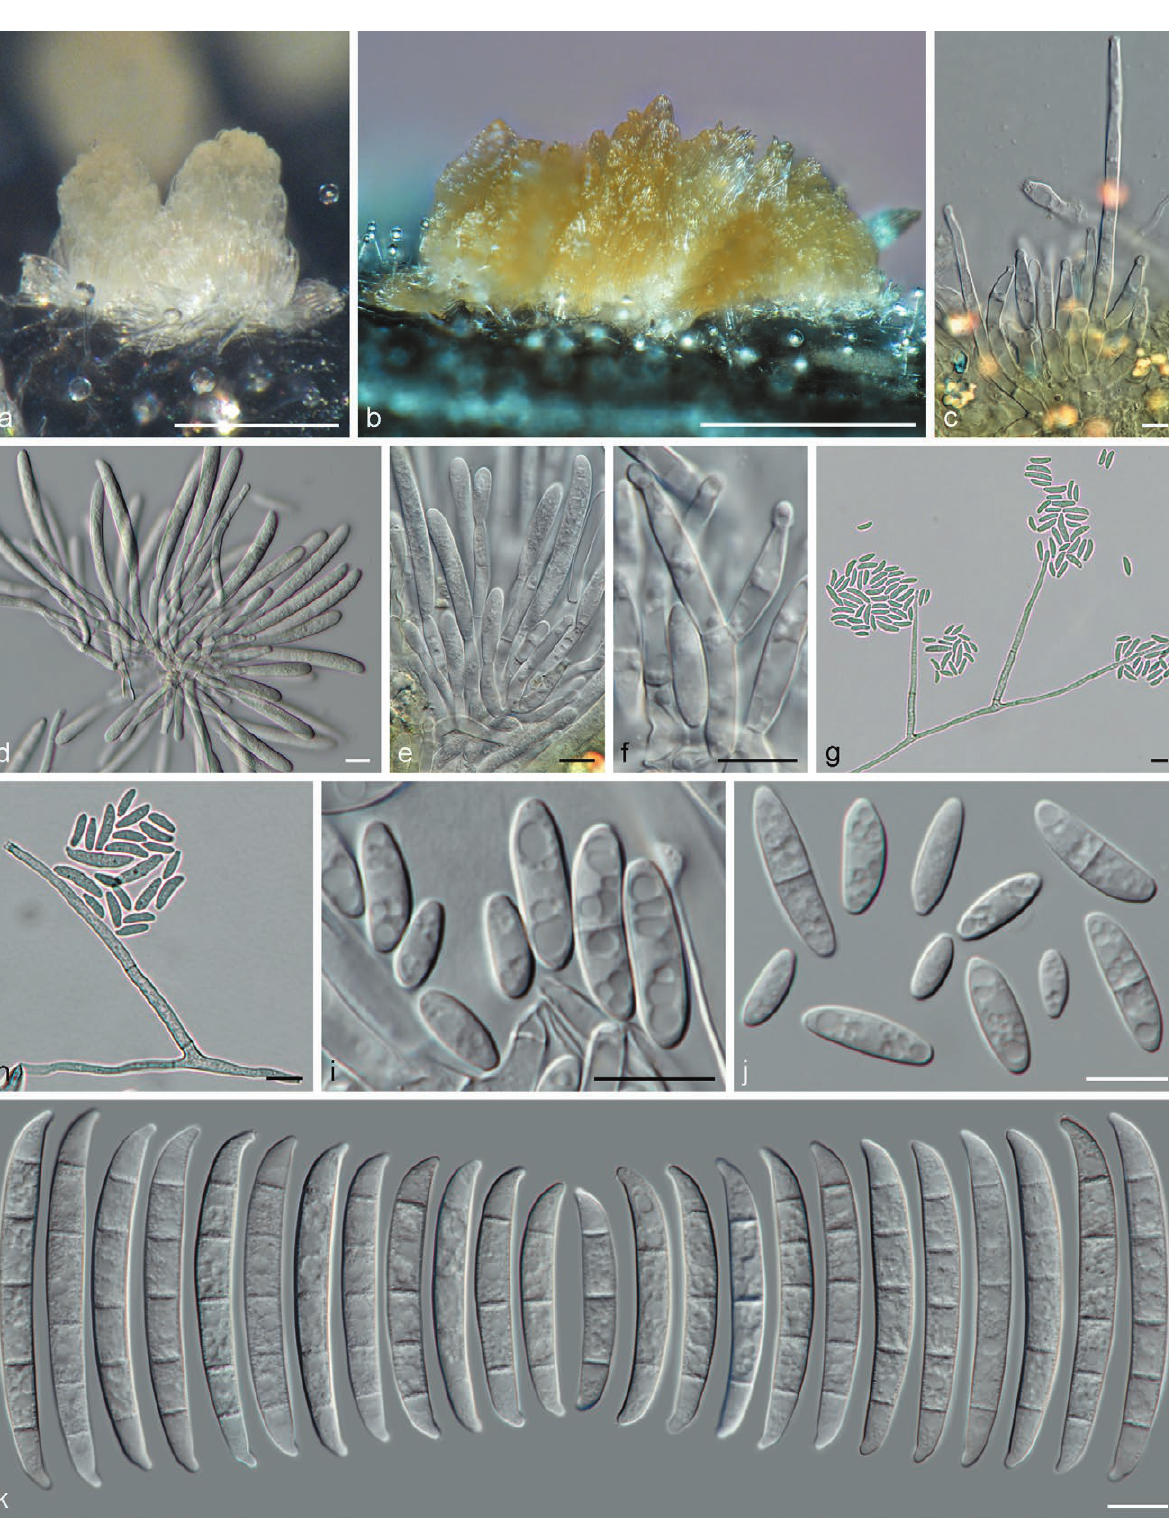
Figure 5. Neocosmospora citricola (ex-type culture CBS 146513). (a and b) sporodochia formed on the surface of carnation leaves; (c to f) sporodochial conidiophores and phialides; (g and h) aerial conidiophores;( I and j) aerial conidia; (k) sporodochial conidia. Scale bars: a and b = 100 μm; c to k = 10